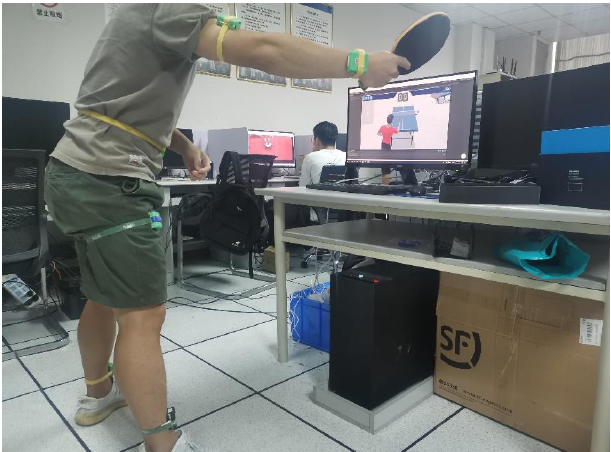
Figure 21. Fast push action training example.